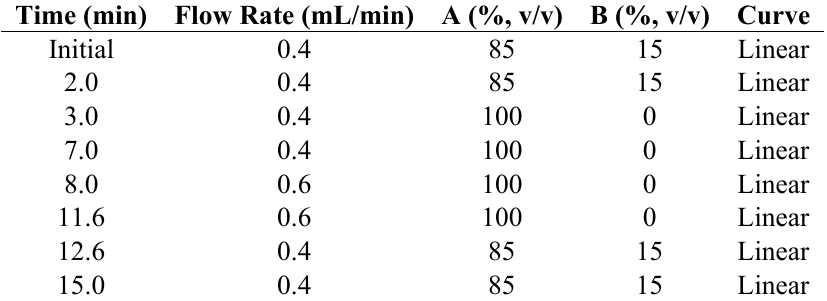
Table 6. Gradient profile used in the chromatographic separation of